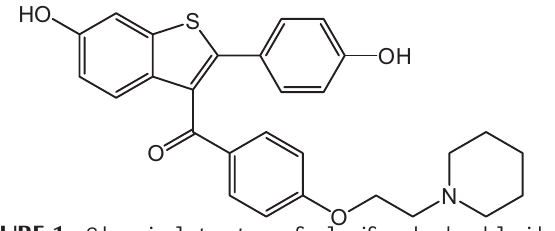
FIGURE 1 - Chemical structure of raloxifene